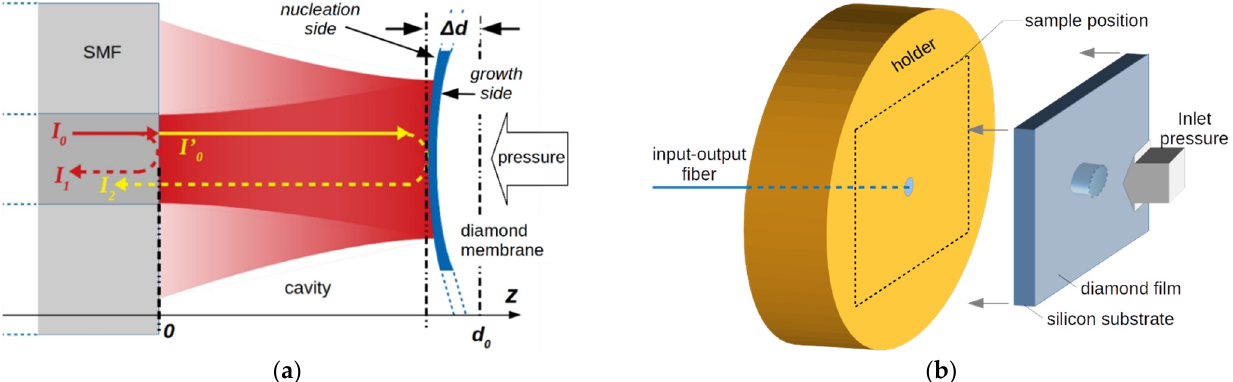
Figure 1. ( a ) Schematic of the FP-cavity of the sensor. The interference signal is generated by reflected beams at the fiber end ( I 1 ) and the diamond membrane ( I 2 ). ( b ) A sketch of the sensing element structure. A thin diamond membrane on silicon is aligned to a single mode fiber to realize a low-finesse FP cavity. The cavity length is equal to the silicon substrate’s thickness.